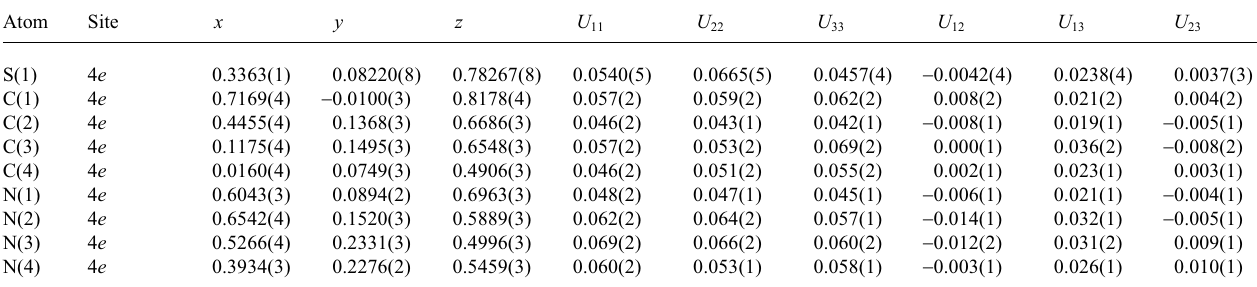
Table 3. Atomic coordinates and displacement parameters (in Å 2 )